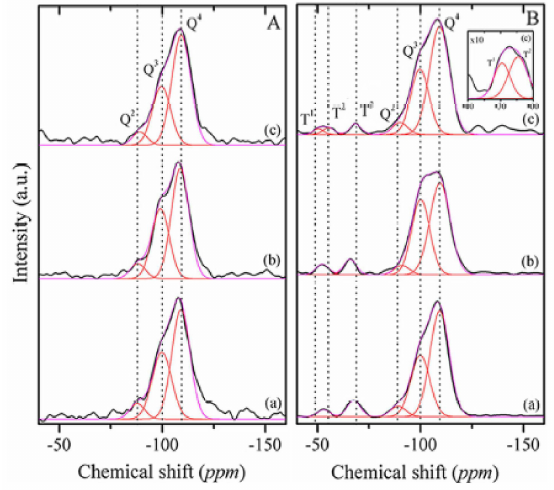
Figure 15. 29 Si MAS-NMR of: ( A ) silica and ( B ) sulfonic acid-functionalized analogues of ( a ) MCM- 41; ( b ) IITM-56; ( c ) SBA-15 from ref [86]. Reprinted with permission from ref. [86]. Copyright 2018 John Wiley and Sons.